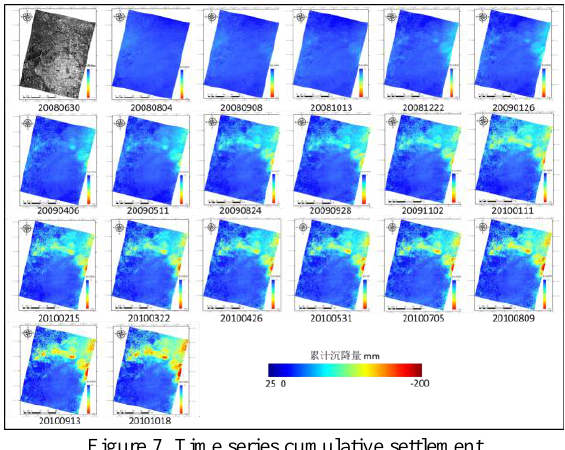
Figure 7. Time series cumulative